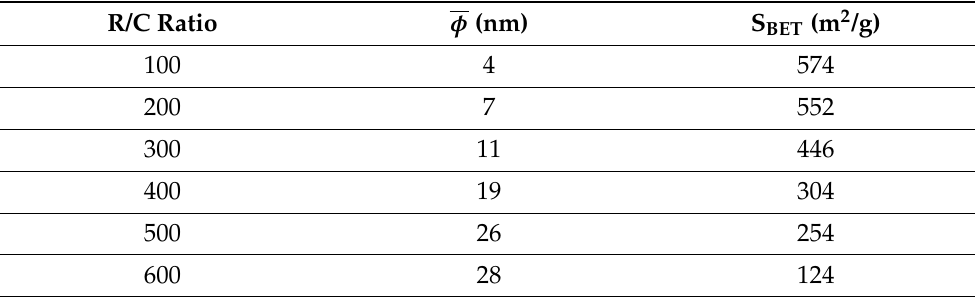
Table 1. The corresponding average pore widths and Brunauer-Emmet-Teller (BET) surface areas. Values are reported to an accuracy less than their error; therefore, their error values have been omitted. Note that S BET is BET surface area, φ is average pore width, and R/C ratio is the molar ratio of resorcinol to